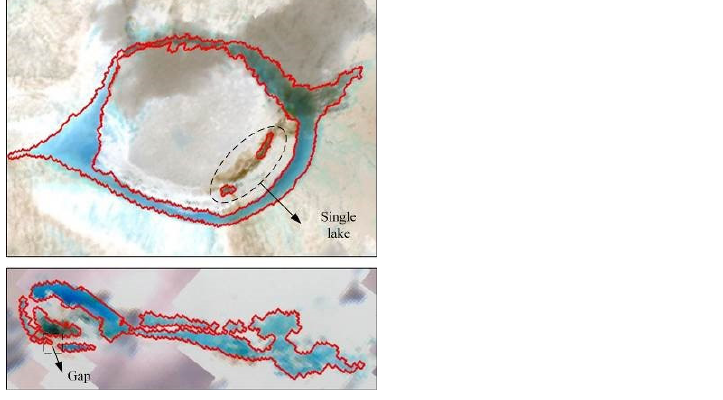
Figure 10. Example of incomplete SGLs. Combined internally independent or externally fragmented lakes with adjacent large water patches were defined as a complete “SGL”. The background image was acquired as with Figure 4.